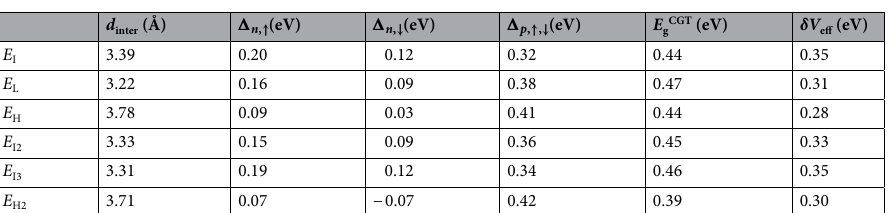
Table 2. Spin-dependent band edges (cid:31) n , effective potential difference, δV eff , obtained by the electrostatic potential difference between the vacuum levels of the FGT and CGT layers in the FM heterobilayer.